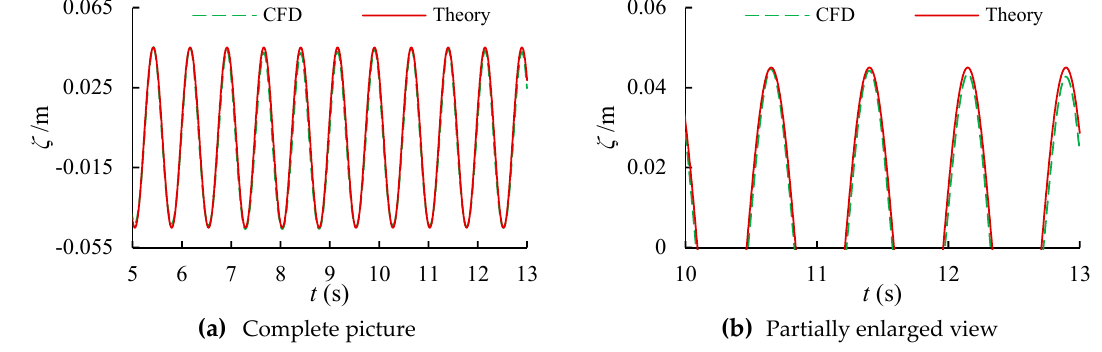
Figure 5. Comparison of calculated and theoretical values.